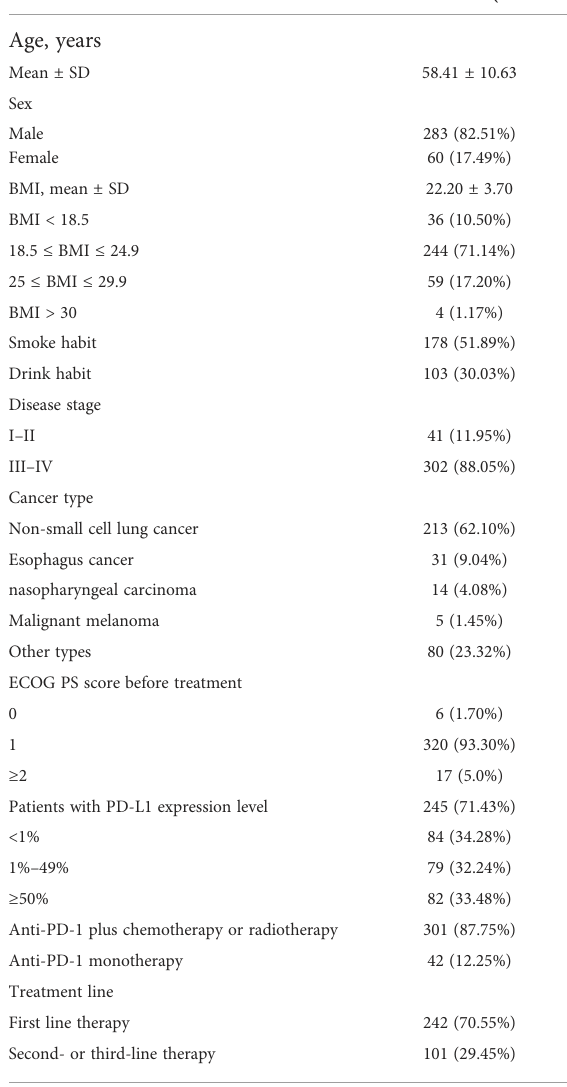
TABLE 1 Demographic and baseline characteristics of enrolled samples.